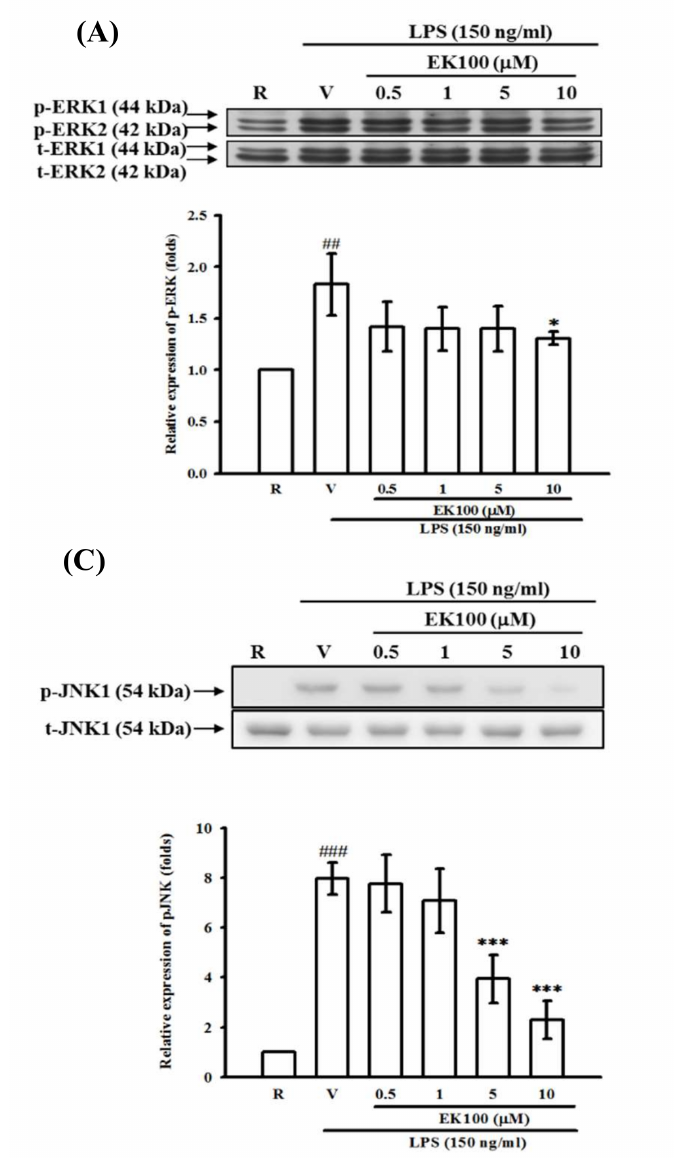
Figure 7. Effects of EK100 on LPS-induced MAPK activation in BV-2 cells. BV-2 cells (2 × 10 5 cells/mL) were dispensed on 6-well plates and pretreated with EK100 (0.5, 1, 5, and 10 µ M) or vehicle (V) for 15 min before stimulation with LPS (150 ng/mL) for the indicated time (30 min for ERK and p38; 45 min for JNK), respectively. The cell lysates were obtained and analyzed for phosphorylated ERK (1/2) ( A ), p38 ( B ), and JNK ( C ) MAPKs by Western blotting methods. The relative changes (folds) were represented as the mean ± SD ( n = 4). ## p < 0.01, ### p < 0.001 compared with the resting group (R); * p < 0.05, ** p < 0.01 compared with the vehicle under